Question: Summarize what this figure shows in one sentence.
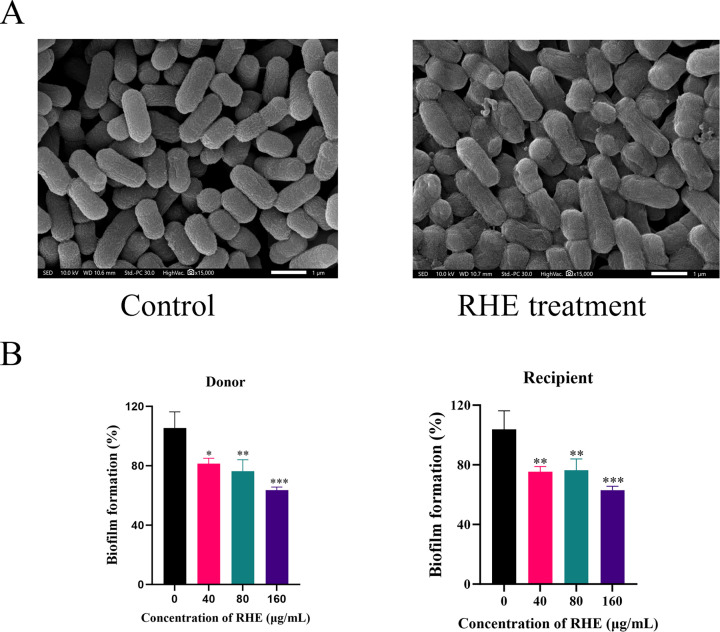
Answer: Rhein disrupts biofilm formation and cell morphology. ( A ) Scanning electron microscopy (SEM) images of bacterial cells. Scale bar = 1 µm. Magnification: ×15,000. ( B ) Quantification of biofilm formation in donor and recipient strains after treatment with 0, 40, 80, or 160 μg/mL RHE. Biofilm formation is presented as the mean ± SD of three biological replicates. Significant differences were evaluated by one-way ANOVA analysis and shown with * P < 0.05, ** P < 0.01, *** P < 0.001, and **** P < 0.0001.